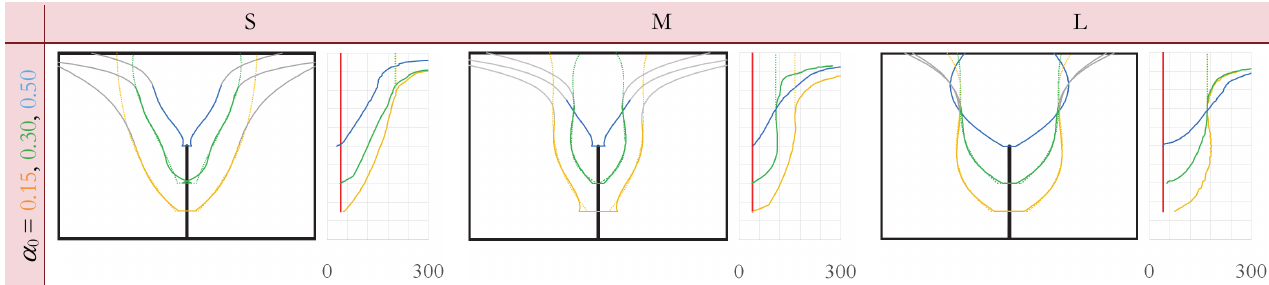
Figure 7: Scheme of the notched beam (the width W is scaled by a factor of 2.42 with respect to the length L ; in reality S/W = 3.3) with the indication of the envelope of the FPZ for the FEM simulated response for each relative crack length; each figure is complemented with R -curve plots (the red line corresponds to the G f value released for the effective crack propagation). The FPZ extent seems to be described by the constructed envelope curves reasonably well except the very beginning and the end of the ligament. The FPZ extent estimation is corrupted at the ligament ends in the cases where significant increases in the R -curve trends are observed. This increase in R in that area is caused by an error of measurement/modelling accumulated at the ends of descending branches of the recorded/simulated loading curves. The odd shape of the FPZ envelope at the beginning of the fracture propagation from the notch (the “fish tail” shape) that is observed mainly for small sizes (D, also C and B for the longest notches) corresponds actually to negative value of W f,fpz